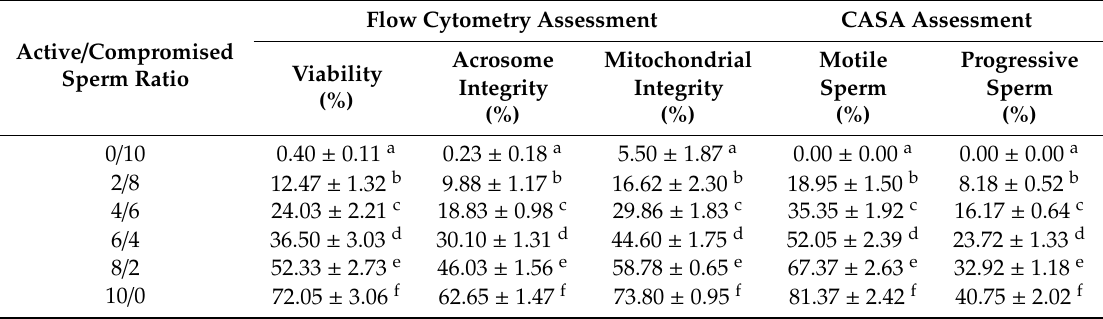
Table 1. Boar sperm parameters assessed with flow cytometry (FC) and computer-assisted sperm analysis